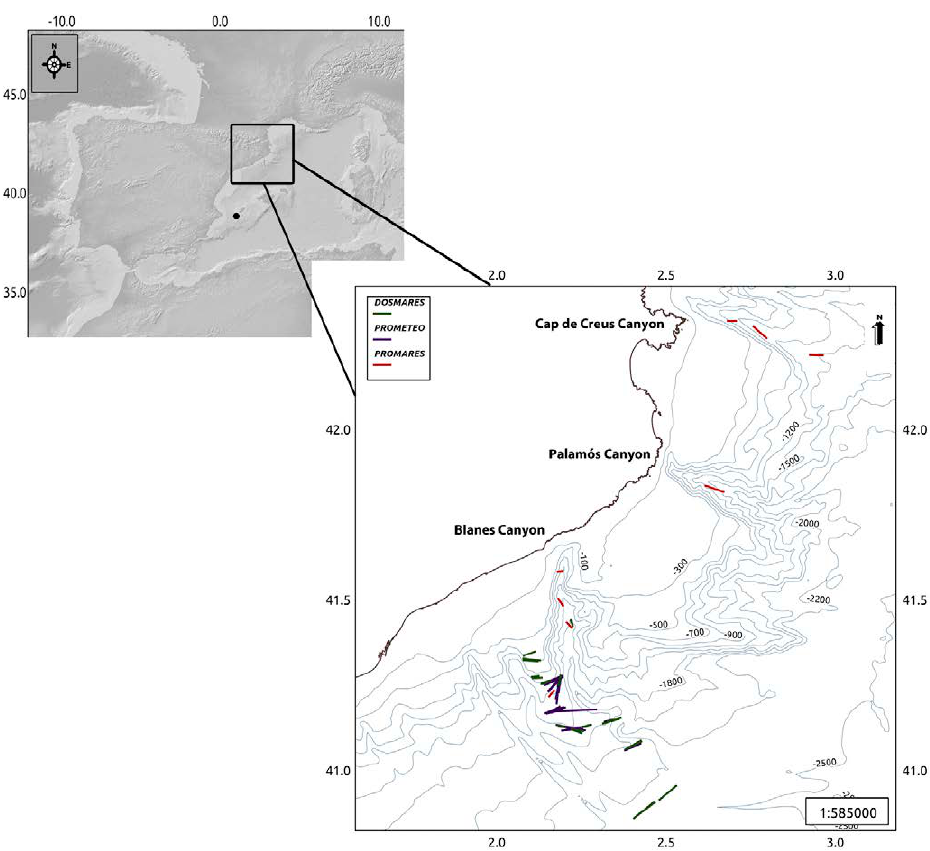
Fig. 1. – Study area. Areas sampled on the cruises PROMETEO, DOSMARES and PROMARES to the Blanes Canyon, Palamós Canyon, Cap de Creus Canyon and the adjacent open slope.